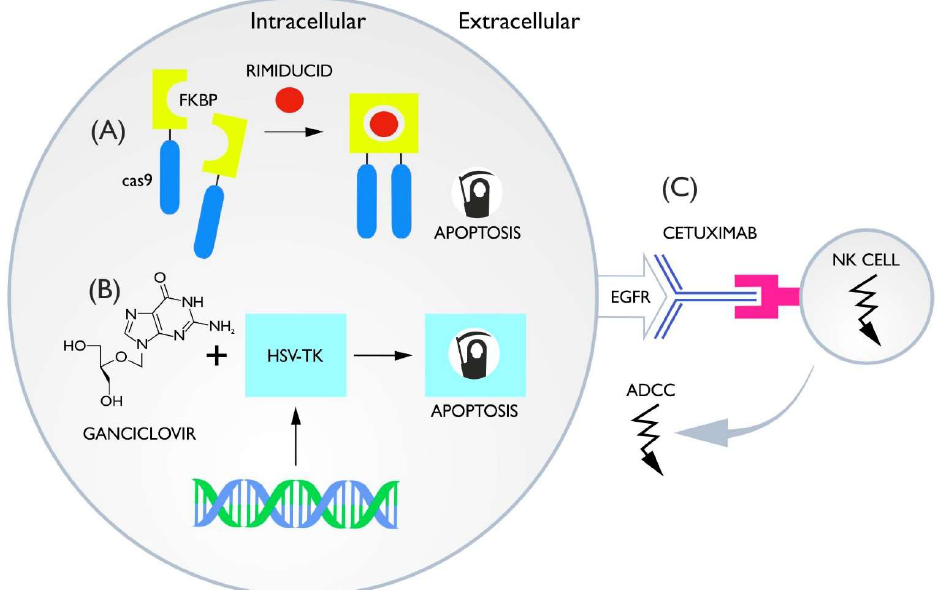
Figure 4. ( A ) Caspase-9 is connected to the homodimerizing protein FKBP. When rimiducid is delivered, homodimerization occurs and caspases send an apoptotic signal to the cell. ( B ) The thymidine kinase (HSV-TK) converts ganciclovir (GCV) into a toxic product and allows selective elimination of TK+ cells in vivo. ( C ) There is a protein on the cell membrane that is a target for the monoclonal antibody. Upon binding of the monoclonal antibody to the epitope, an antibody-dependent cytotoxic effect is induced by NK cells.